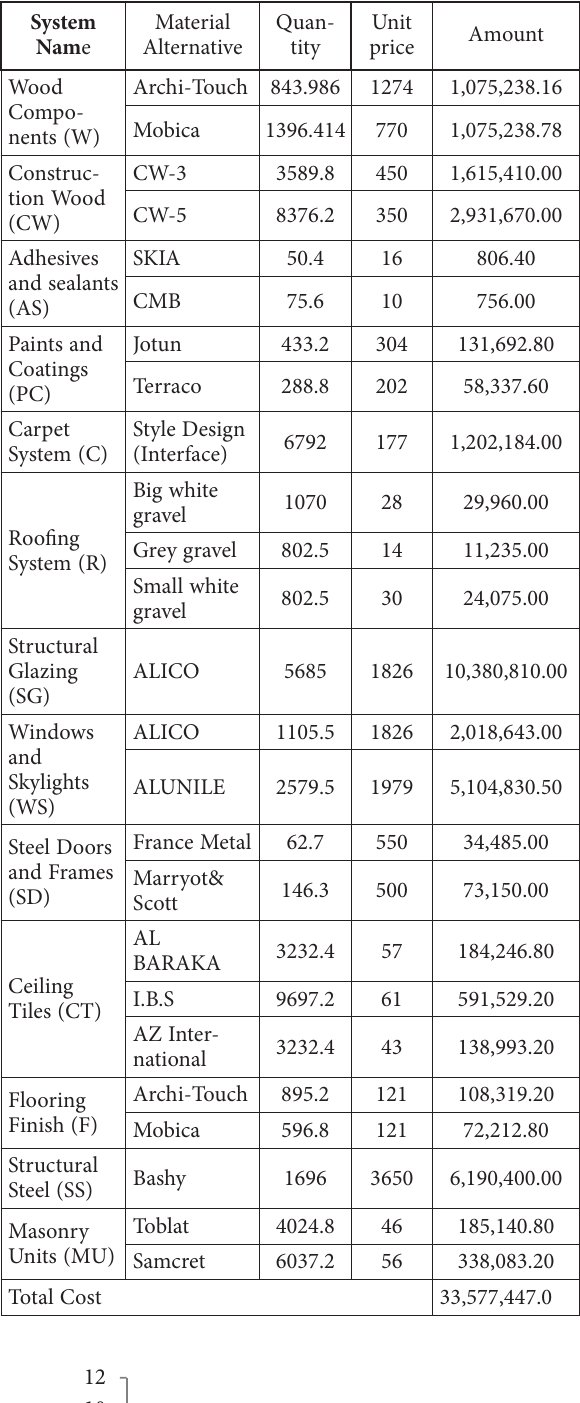
Table 5. Case study selected materials